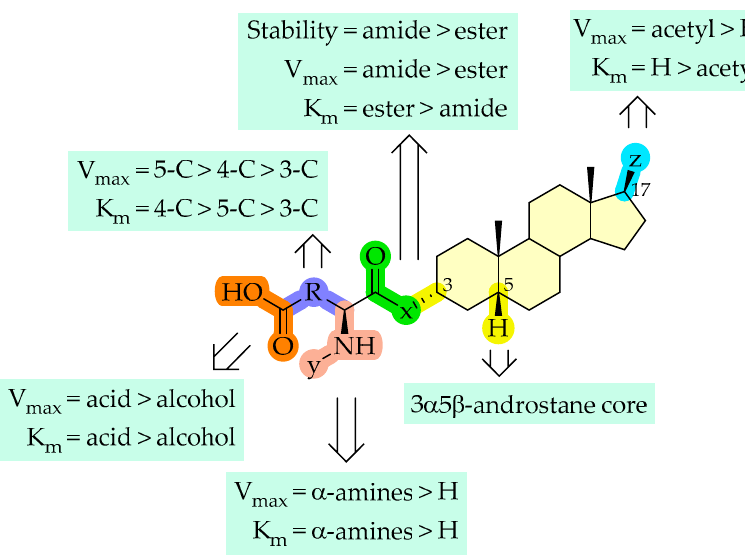
Figure 8. Summary of structure-uptake relationships of neurosteroids.